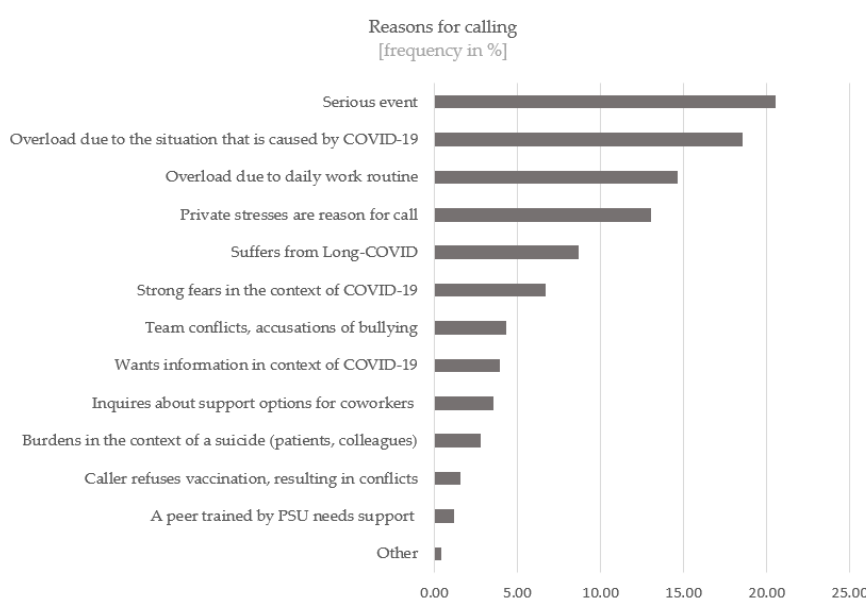
Figure 2. Reasons for calling at PSU ‐ HELPLINE.